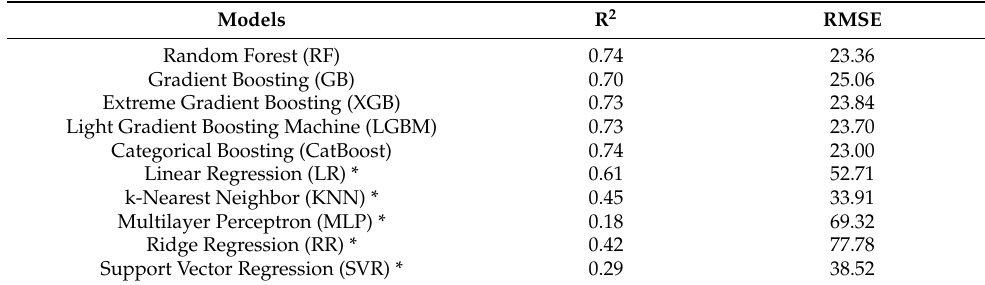
Table 2. Performance of the ten models in the pre-test. * denotes that the model was eliminated due to the low R 2 and high RMSE.